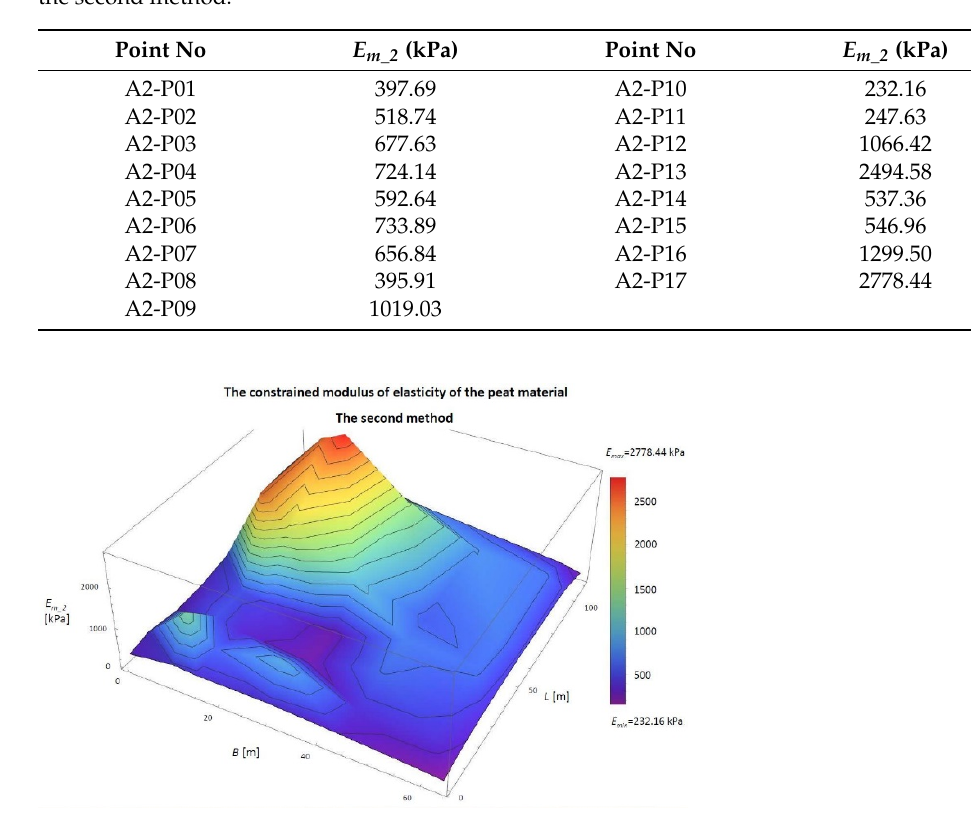
Table 8. Value of the constrained modulus of elasticity in Szczecin on the Ostrów Brdowski island by the second method.